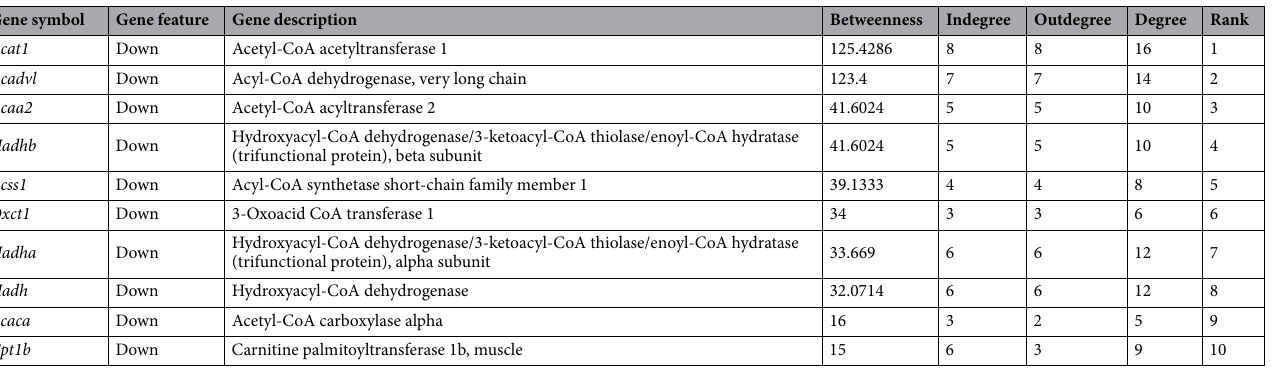
Table 5. Top 10 hub genes from gene signal network analysis based on betweenness (in order of decreasing betweenness-value).